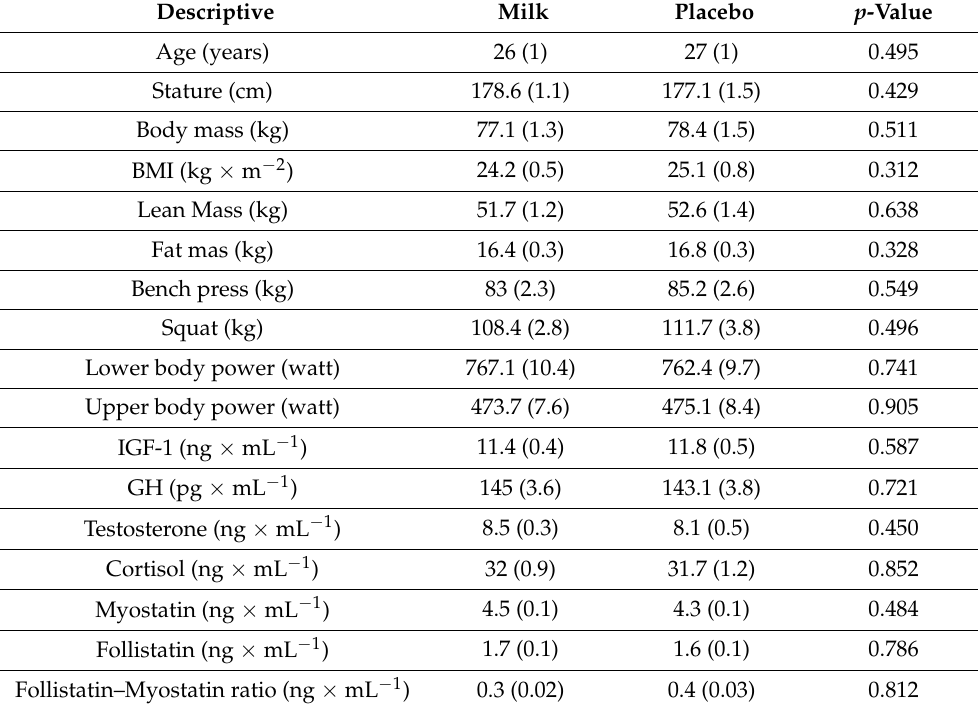
Table 1. Descriptive characteristics of participants’ values represent mean, standard error in brackets. Descriptive Milk Placebo p -Value Age (years) 26